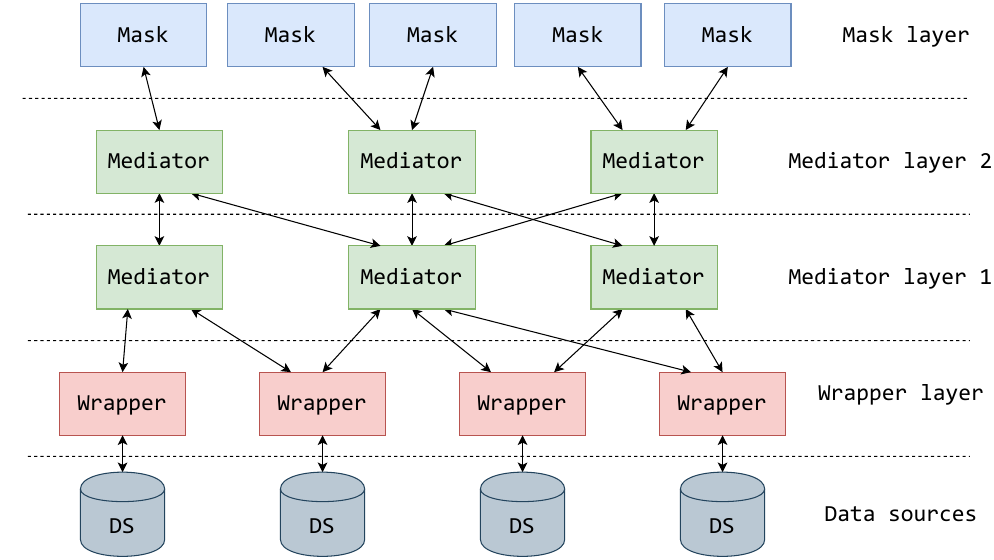
Figure 7. The MMW architecture with layered